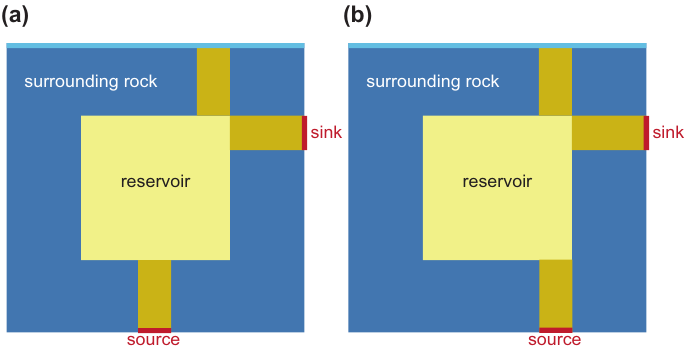
Figure 8. Setting of locations of heat sources for test data.The positions of heat sources are set to ( a ) bottom center and ( b ) bottom